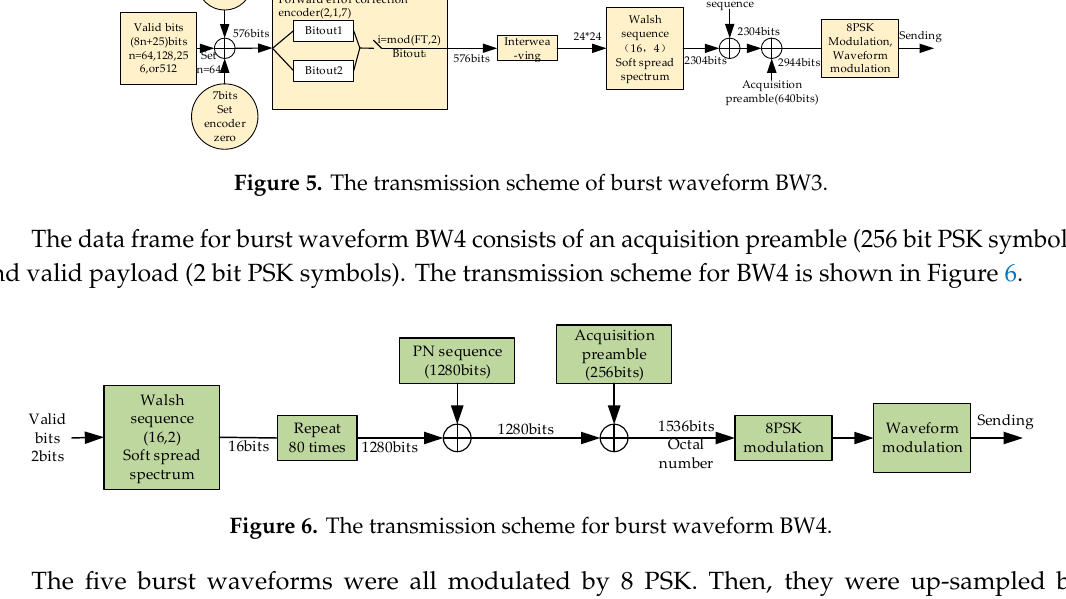
Figure 4. The transmission scheme of burst waveform BW2. FT: forward transmission.